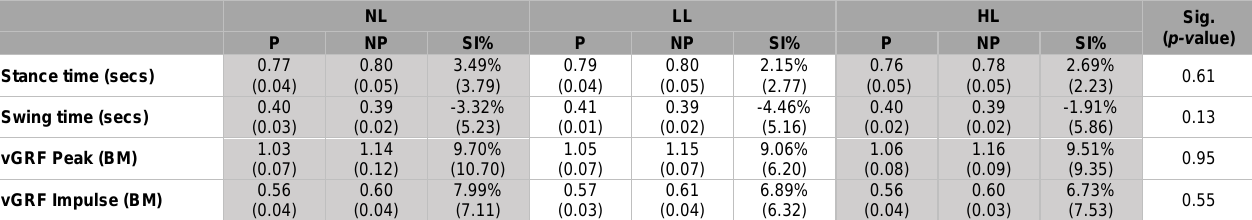
Table 3: Mean (SD) temporal and GRF measures for the three load conditions. NL= No load, LL= Light load, HL= Heavy